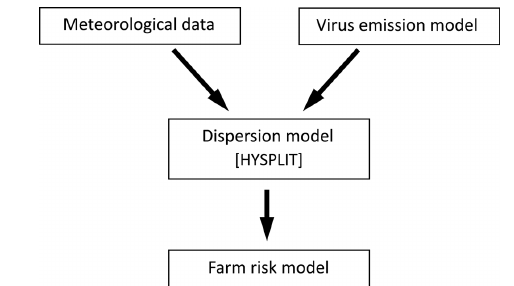
Figure 1. The four primary components of the Foot and Mouth Disease dispersion system. At its core is the NOAA-ARL HYSPLIT model which had minor additions made to it so it could better model the bio-meteorological characteristics of the FMD